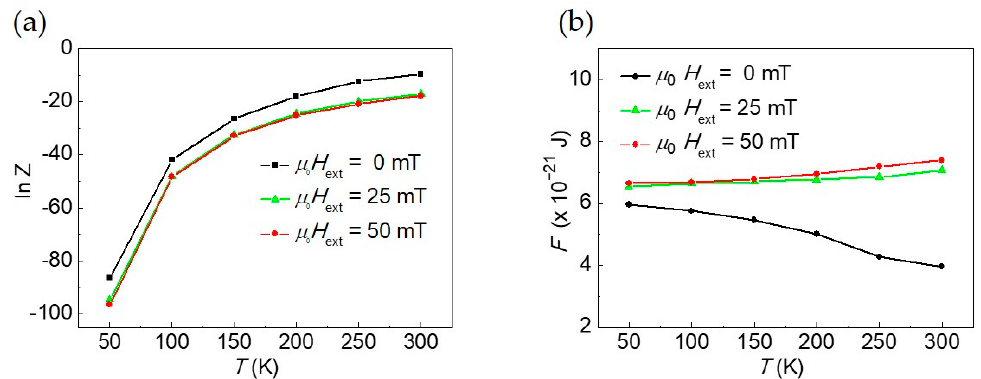
Figure 4. ( a ) Partition function vs. T at µ 0 H = 0 mT (black line with squares), µ 0 H = 25 mT (green line with up triangles), and µ 0 H = 50 mT (red line with diamonds); ( b ) As in panel ( a ) but for the Helmholtz free energy F .